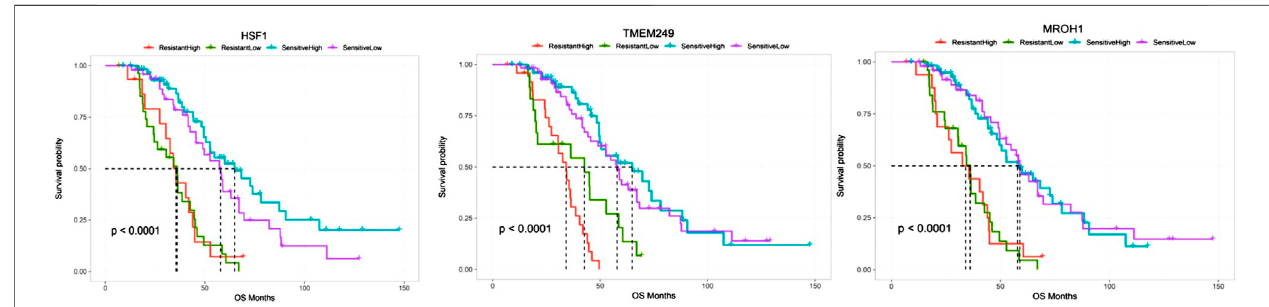
FIGURE 8 | Comparing the overall survival between chemo-resistant and -sensitive expression of HSF1, TMEM249, and MROH1 using the CVCDAP portal for ovarian cancer patients. The plot shows a signi fi cant reduction in the overall survival across patients resistant to chemotherapy and expressed a high level of HSF1, TMEM249, and MROH1 genes in comparison with sensitive samples. Moreover, the plot indicates that high expression of MROH1 and TMEM249 in chemo-sensitive samples can reduce OS among these patients.